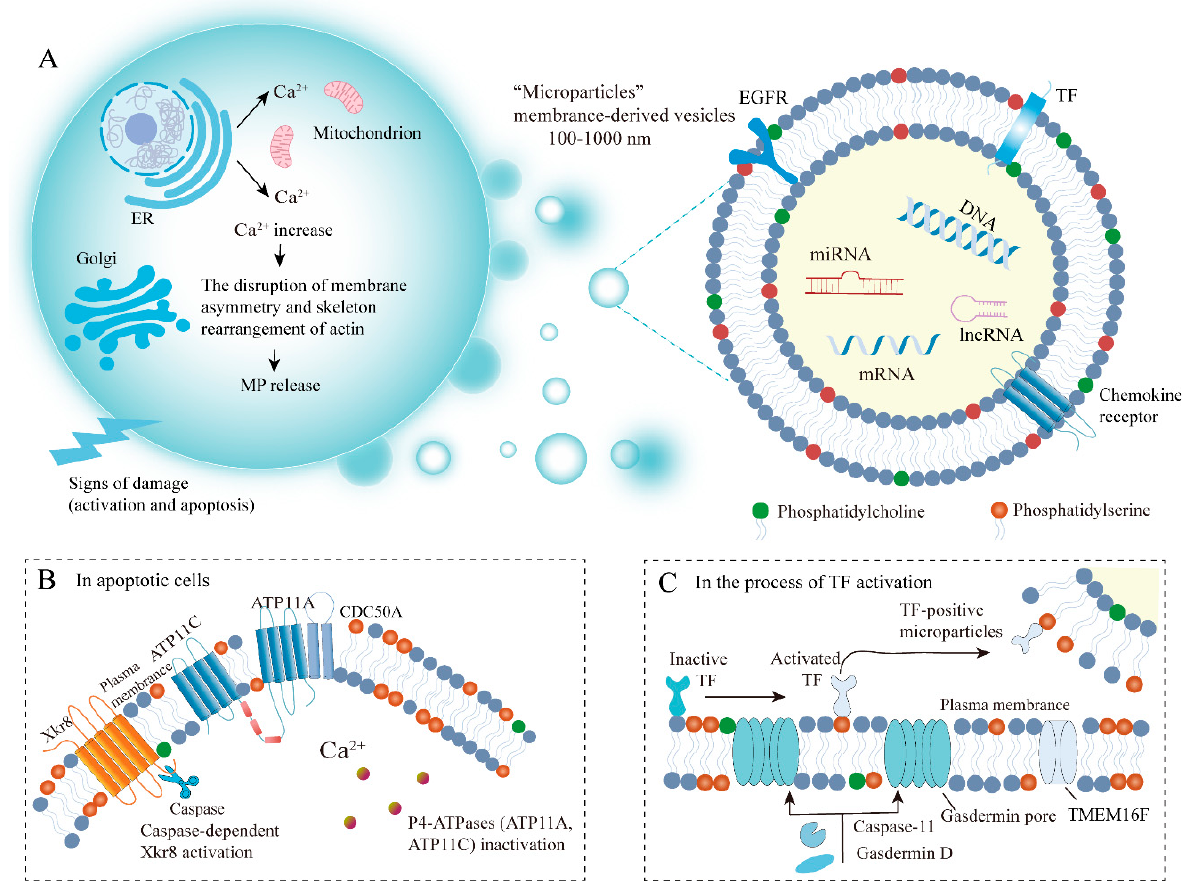
Figure 1. Mechanisms of MP formation and PS externalization. ( A ) Signs of damage (activation and apoptosis) cause increased cytosolic Ca2+ concentration, induce membrane asymmetry disruption and actin cytoskeletal rearrangement and promote MP release. ( B ) In cells undergoing apoptosis, caspase-dependent Xkr8 activation and P4-ATPase inactivation together result in persistent PS exposure. ( C ) In the process of TF activation controlled by caspase-11- and gasdermin D-dependent pathways, PS exposure is mediated by TMEM16F. EGFR; Epithelial growth factor receptor; MPs: microparticles; PS: phosphatidylserine; Xkr8: Xk-related protein 8; TF: Tissue factor, TMEM16F: Transmembrane protein 16F.